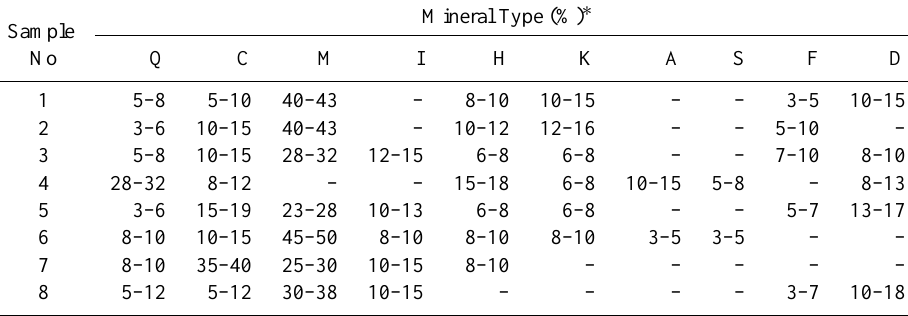
Table 3. Average mineral composition of the samples from the XRD results. Sample